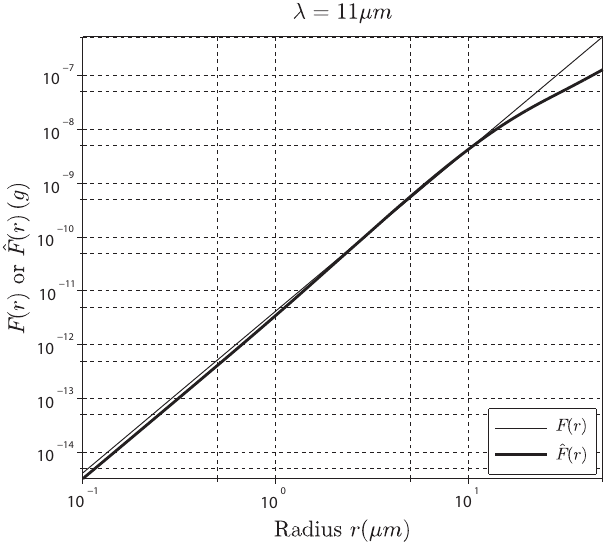
F(r) and ˆ F(r) (in